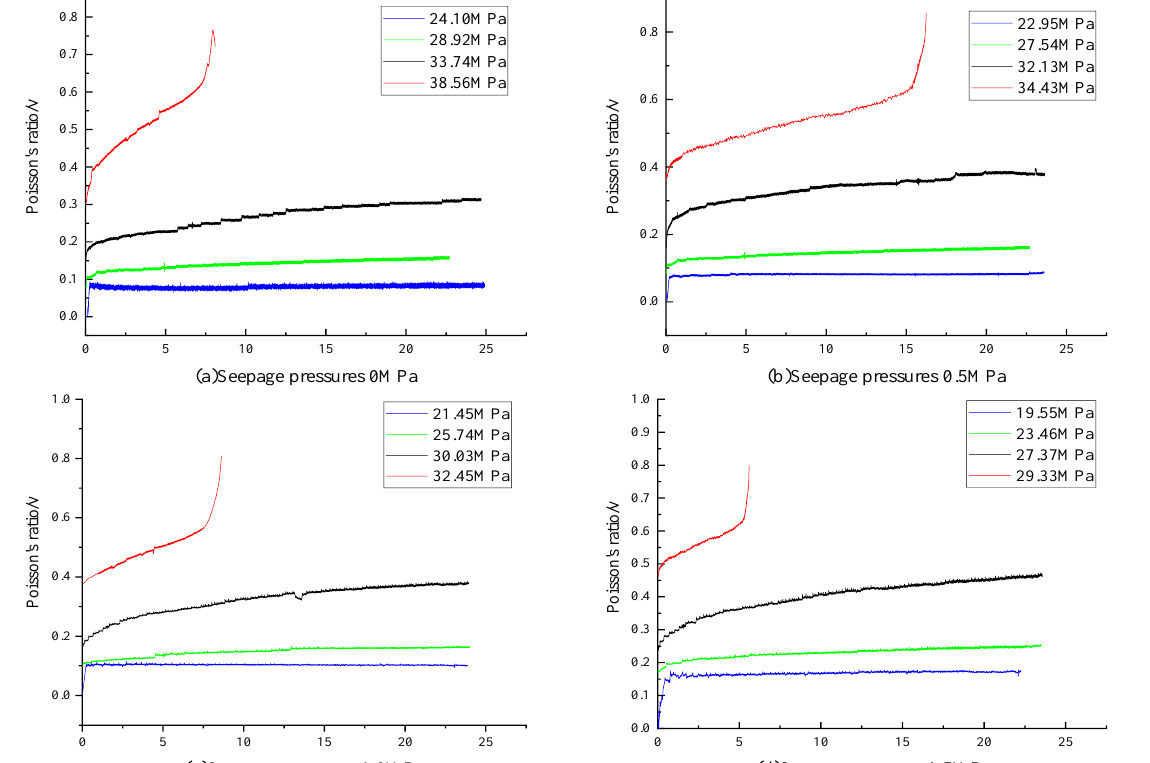
Figure 9. Poisson ’ s ratio – time curve under different seepage pressure. Figure 9. Poisson’s ratio–time curve under different seepage